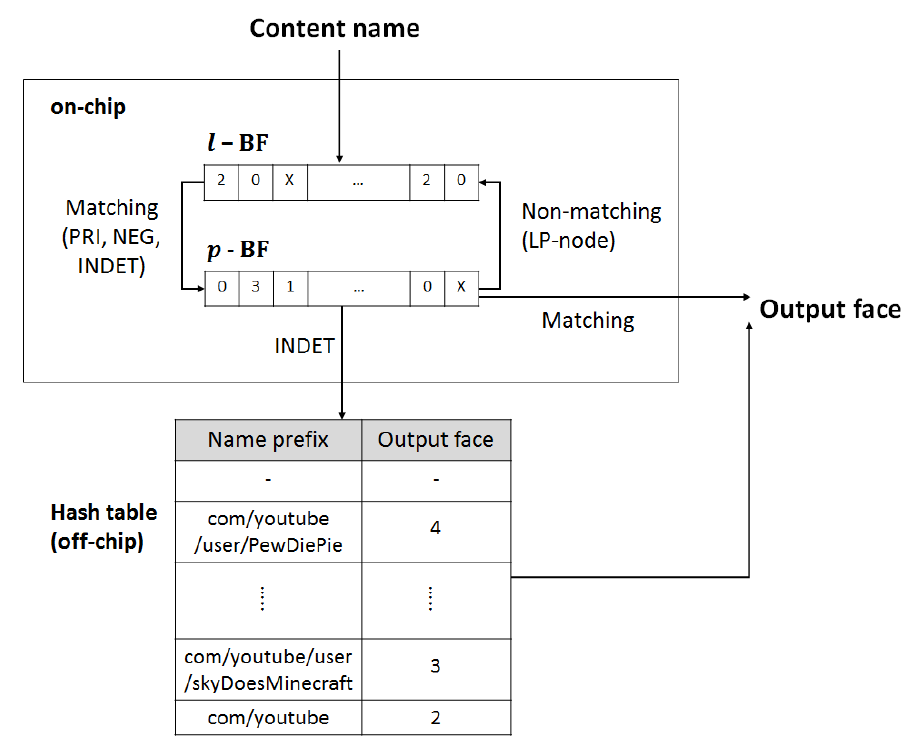
Figure 3. Proposed 2-phase Bloom filter